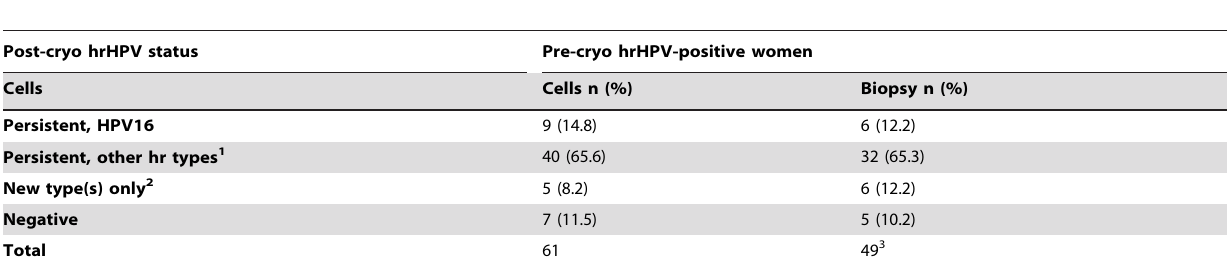
Table 2. Presence of hrHPV after cryotherapy (cryo) by type of pre-cryo sample in women who were hrHPV-positive before